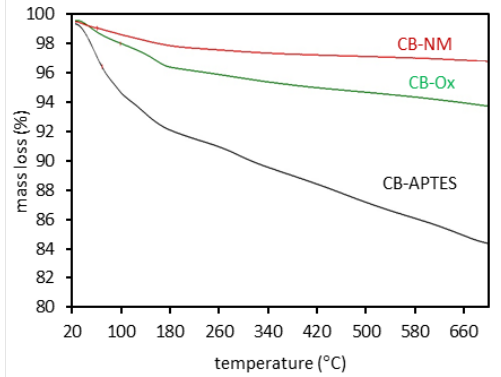
Figure 3. Mass loss (TG curves) for carbon black samples.